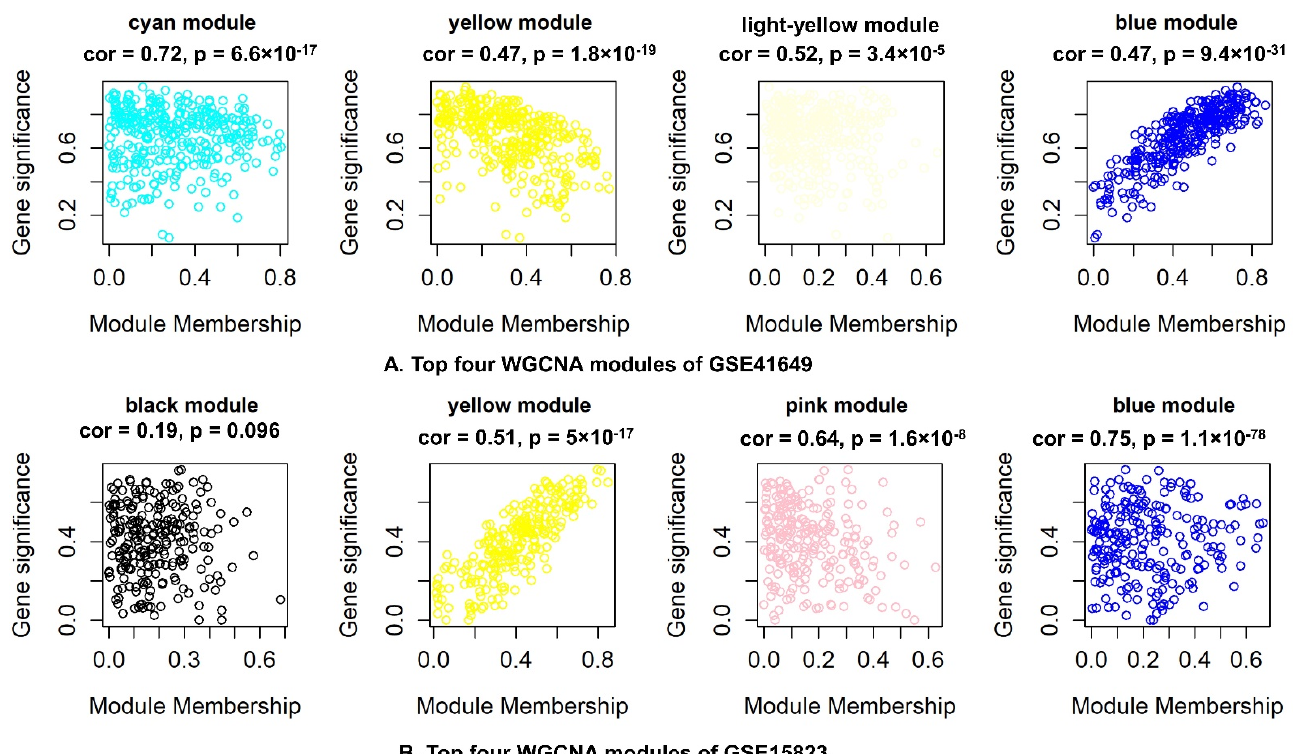
Figure 9. Identification of top four WGCNA modules of datasets with Pearson’s correlation between module membership (MM) and gene significance (G.S.). Top four modules of ( A ) GSE41649 ( B ) GSE15823.